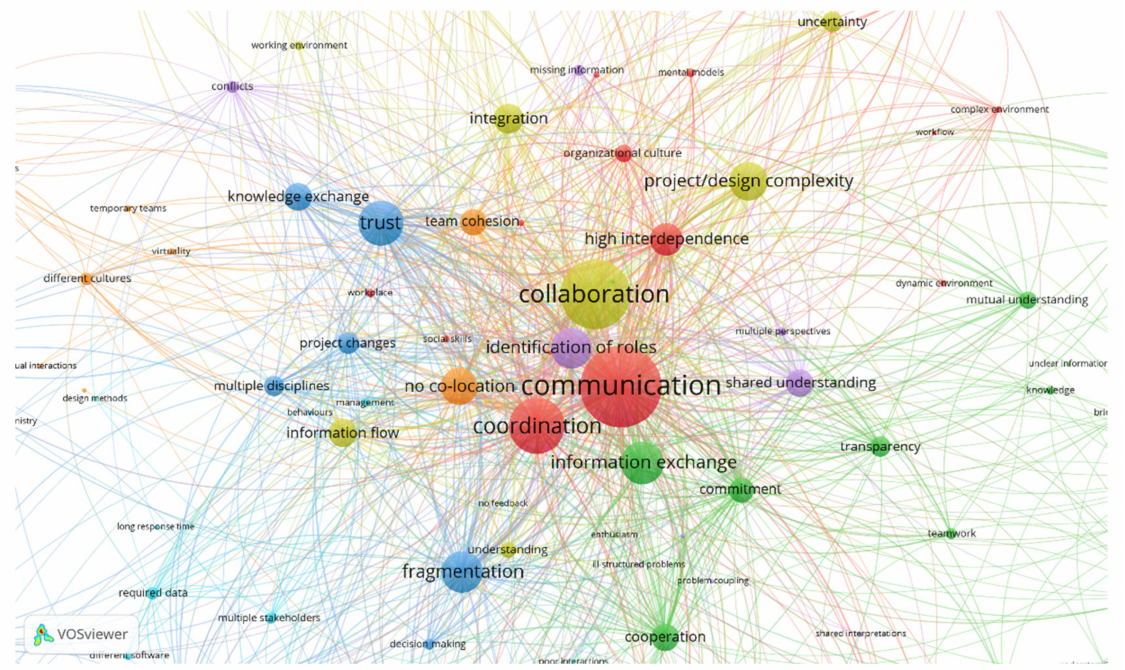
Figure 8. Co-occurrence of the main identified